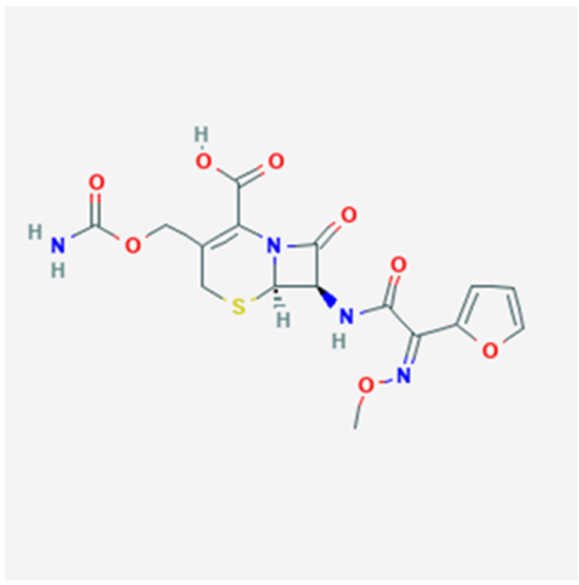
Figure 1. Chemical structure of the antibiotic